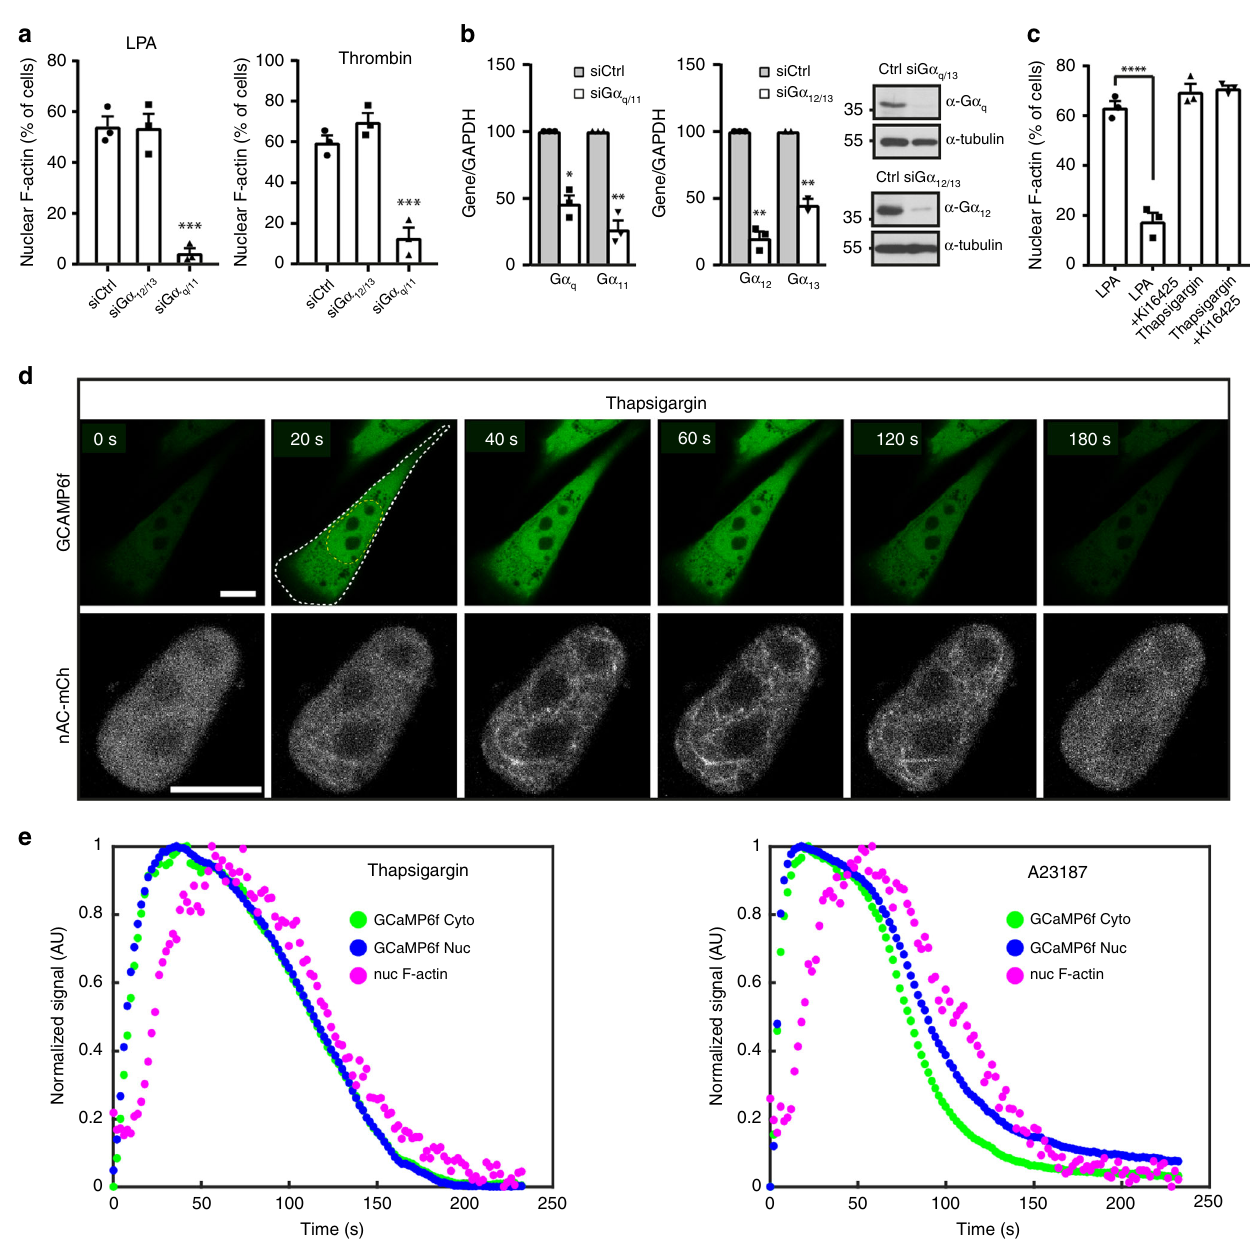
Fig. 2 GPCR ligands induce nuclear F-actin via G α q/11 and calcium. a After transfection with different siRNAs, NIH3T3 cells stably expressing nAC-GFP were stimulated with LPA or thrombin. n = 3 independent experiments. One-way ANOVA test, *** p ≤ 0.001. b Western blots and qPCR showing knockdown ef fi ciency of respective siRNAs. Two-sided Student's t test, * p ≤ 0.05, ** p ≤ 0.01. c NIH3T3 cells stably expressing nAC-GFP were stimulated with LPA or thapsigargin after pre-treatment with or without Ki16425. n = 3 independent experiments. One-way ANOVA test, **** p ≤ 0.0001. Error bars: + s.e.m. d After transfection with GCaMP6f, NIH3T3 cells stably expressing nAC-mCherry were stimulated with thapsigargin. Image sequences from a representative cell out of 35 NAA-positive cells are shown. White and yellow dashed lines indicate the region of interest for quanti fi cation. Scale bars: 10 μ m. e Quanti fi cation of the fl uorescent signals after thapsigargin or A23187 treatment showing nuclear F-actin formation after intracellular calcium release. Source data are provided as a Source Data fi